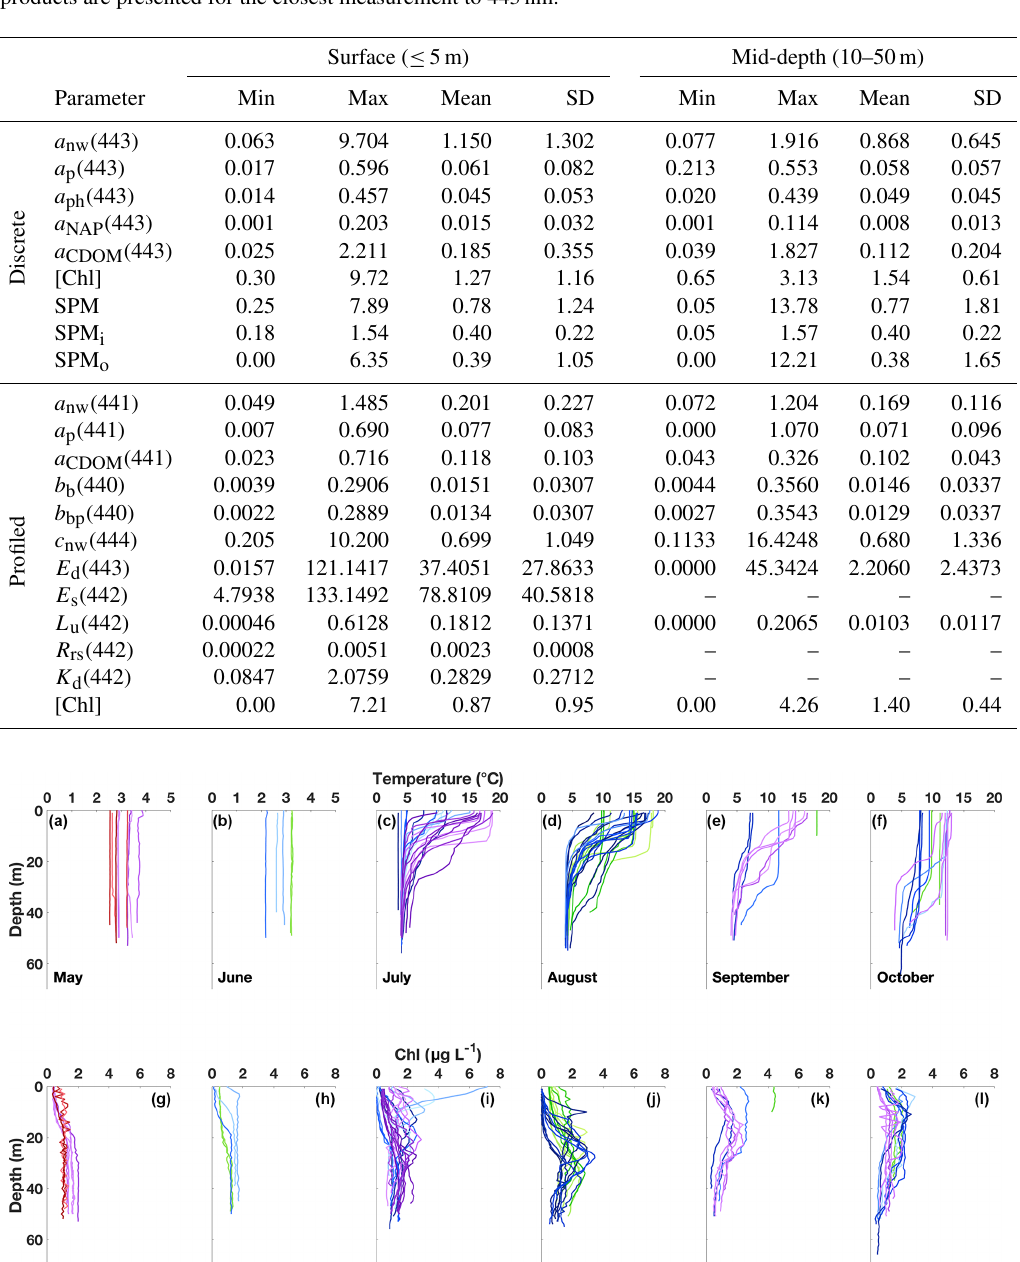
Figure 2. Profiles of temperature (a–f) and [Chl] retrieved from in situ fluorescence (g–l) for the Lake Superior dataset. The profiles are colored by year and shaded by longitude as in Fig. 1. Data are binned by 1m. Note the compressed x -axis limits for temperature profiles in May and June (a, b) . Throughout the region, water column stratification is not observed until July or even August (c, d) and is eroded in the fall (f) . Absolute [Chl] levels are low throughout the lake, even during spring and summer months (g–l)